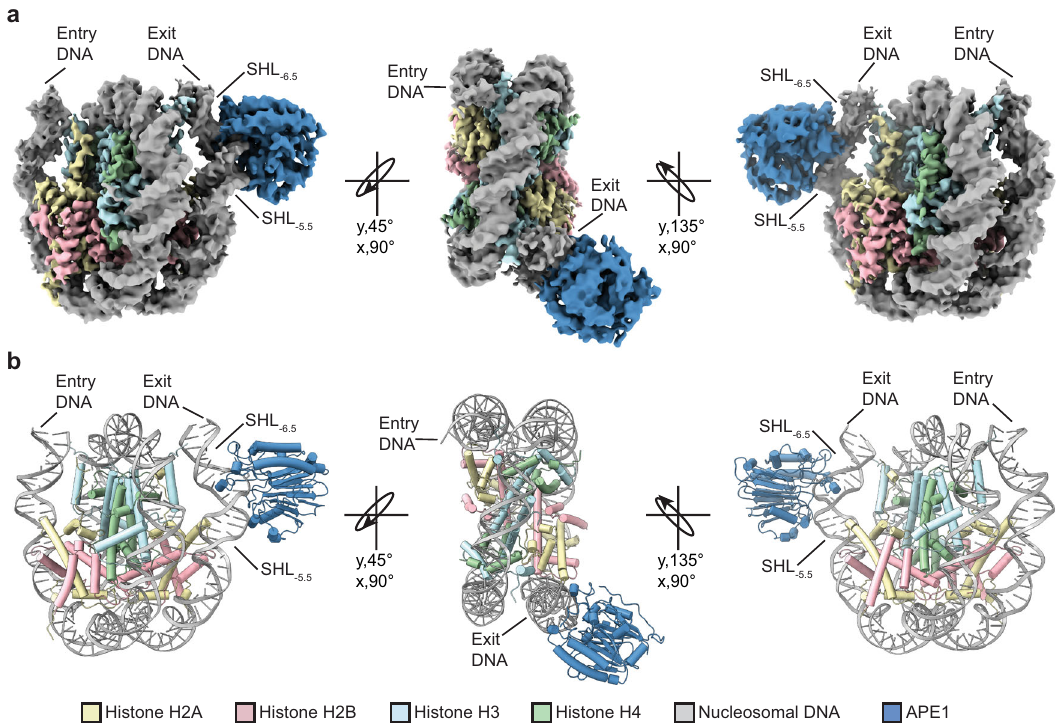
Fig. 2 | Cryo-EMstructureoftheAPE1-AP-NCP -6 complex. a A sharpened cryo-EM map of the APE1-AP-NCP complex in threedifferent views. b Model of the APE1-AP- NCP -6 complex shown in the same three orientations as